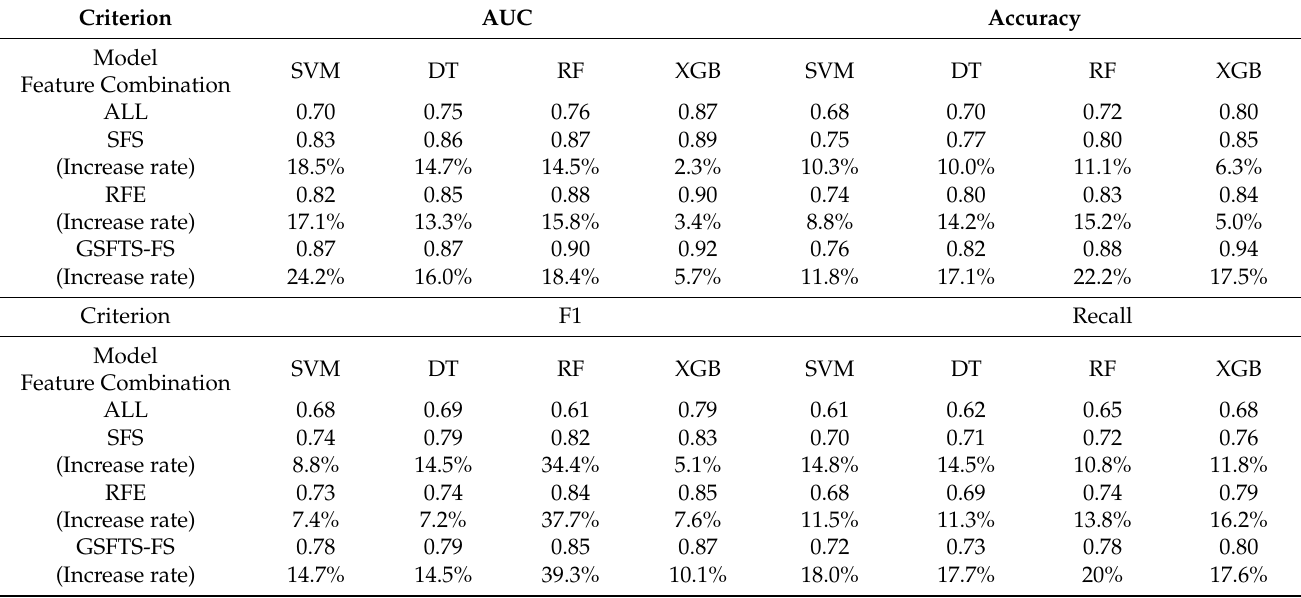
Table 9. Prediction results of different methods and criterion on test